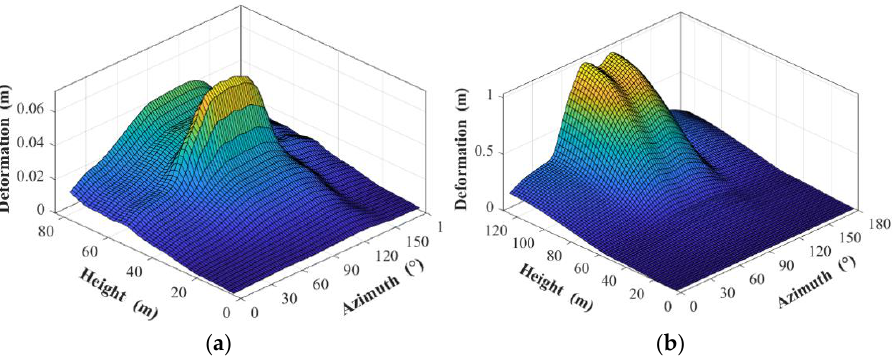
Figure 18. Mean deformation of the quayside cranes: ( a ) boom-down state; and ( b ) boom-up state.